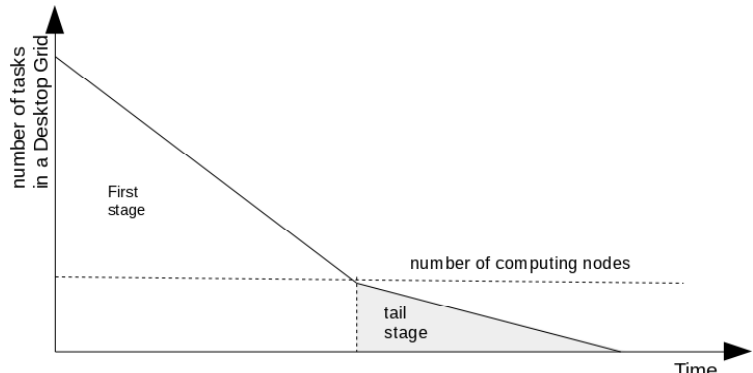
Figure 1: Two stages of batch completion in a Desktop